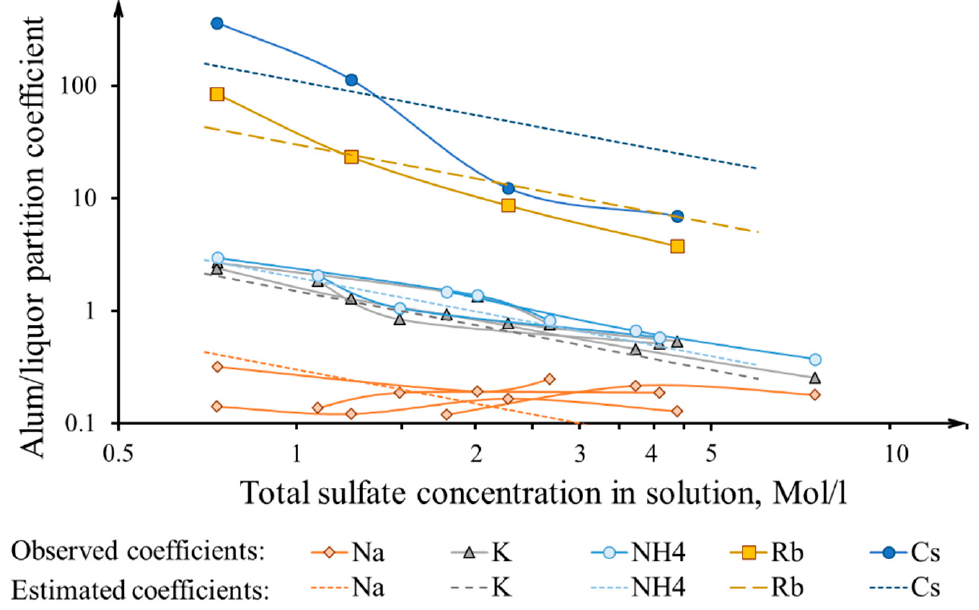
Figure 6. Distribution of alkali metal and ammonium ions between the solid alum and the liquid phases (dashed lines—theoretical dependencies).